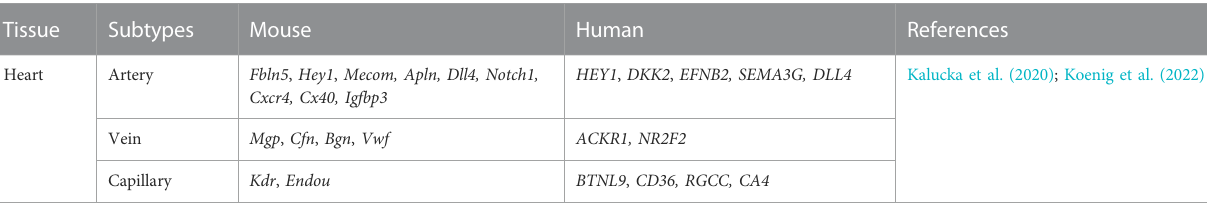
TABLE 1 ( Continued ) Marker genes in organ-speci fi c vascular